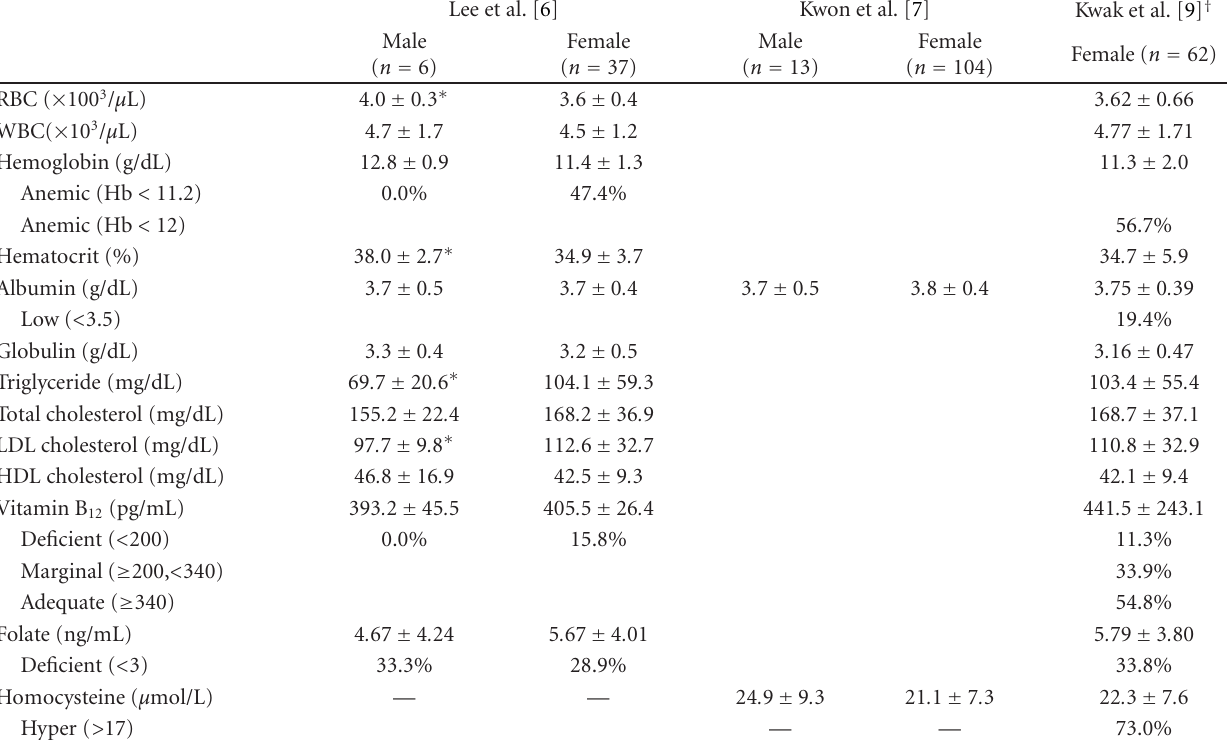
Table 2: Blood biochemical variables including vitamin B 12 level of Korean centenarians.